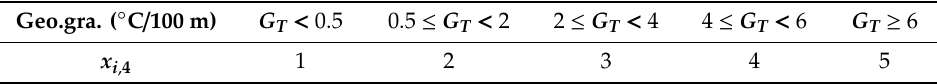
Table 4. Performance values x i ,4 for 4th criterion.